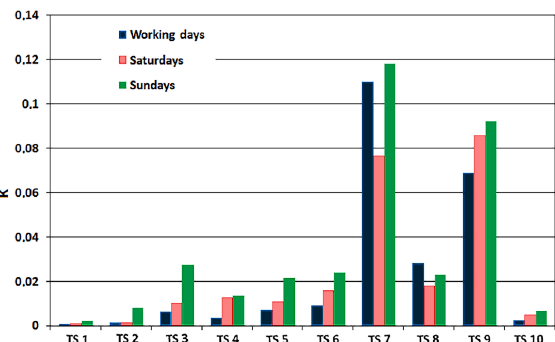
Fig. 14. Relative energy recovered by trolleybuses in supply areas of several substations